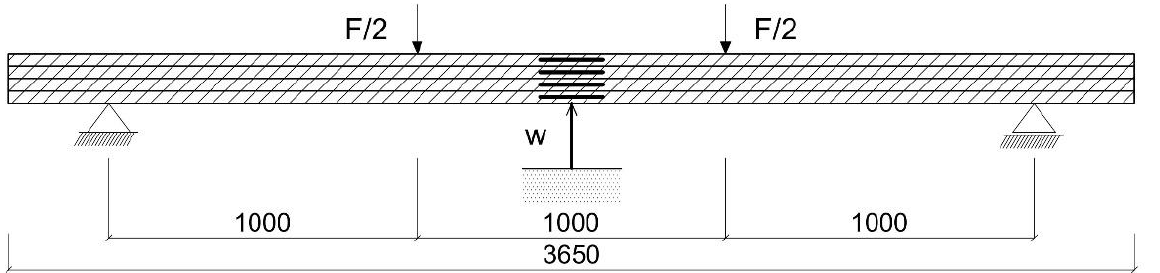
Figure 2. Four-point bending test.